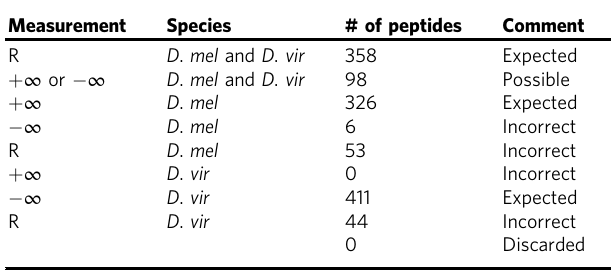
The table shows the number of peptides that were identi fi ed and quanti fi ed depending on quantitative measurement (ratio value R , log 2 -transformed) and species speci fi city with no ion count threshold (Supplementary Data 1)